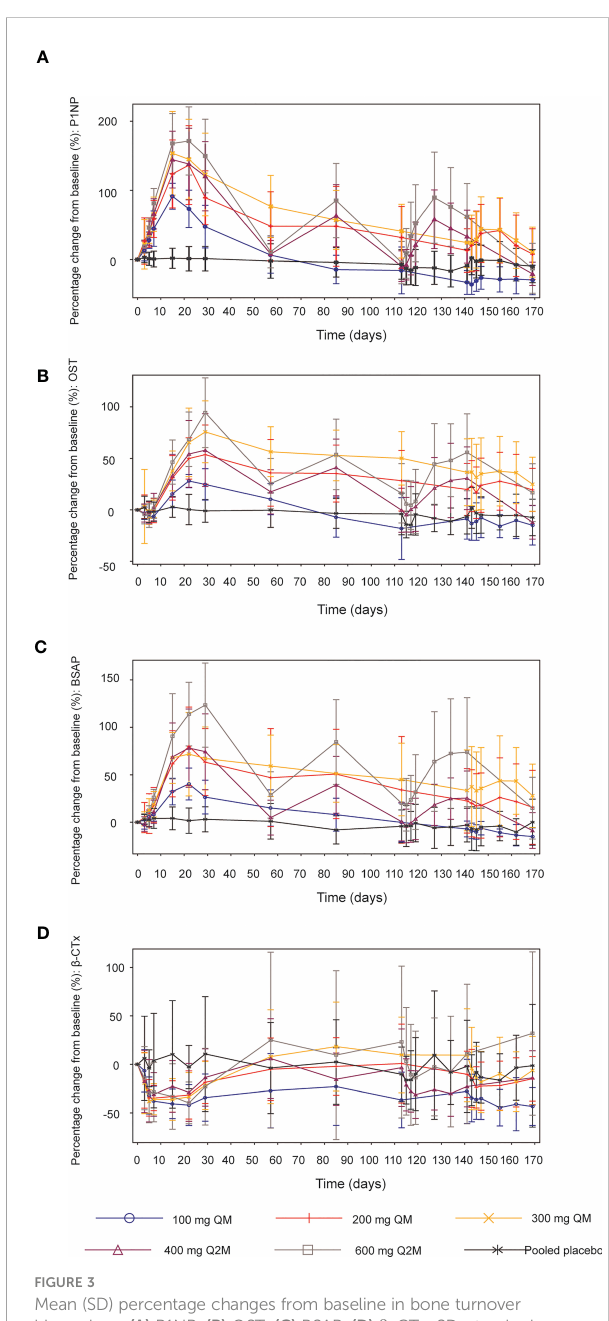
FIGURE 3 Mean (SD) percentage changes from baseline in bone turnover biomarkers. (A) P1NP. (B) OST. (C) BSAP. (D) b -CTx. SD, standard deviation; QM, once every month; Q2M, once every 2 months; P1NP, N-terminal propeptide of type 1 procollagen; OST, osteocalcin; BSAP, bone-speci fi c alkaline phosphatase; b -CTx, b